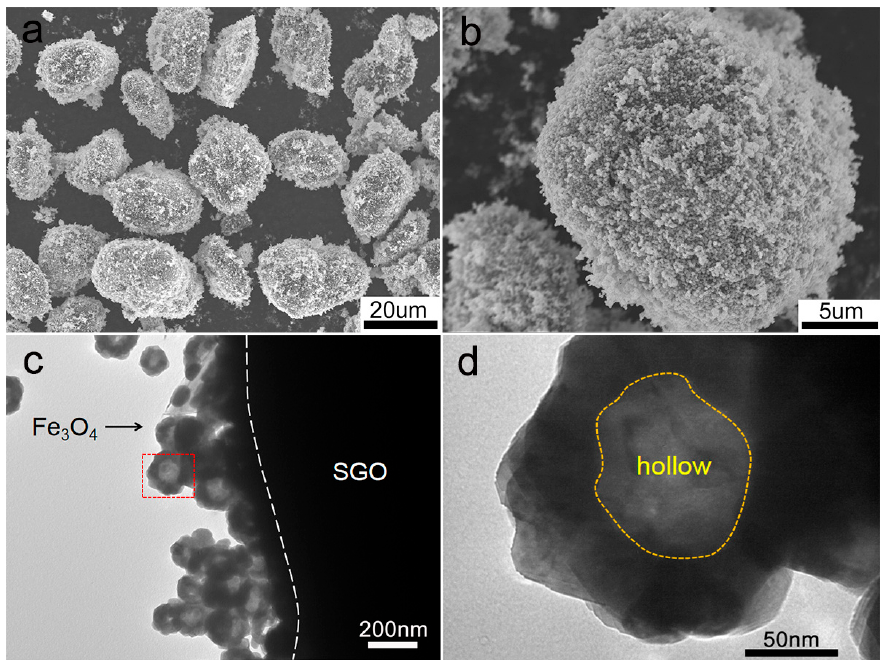
Figure 3. ( a , b ) SEM images and ( c , d ) TEM images of SGO/Fe 3 O 4 -4.